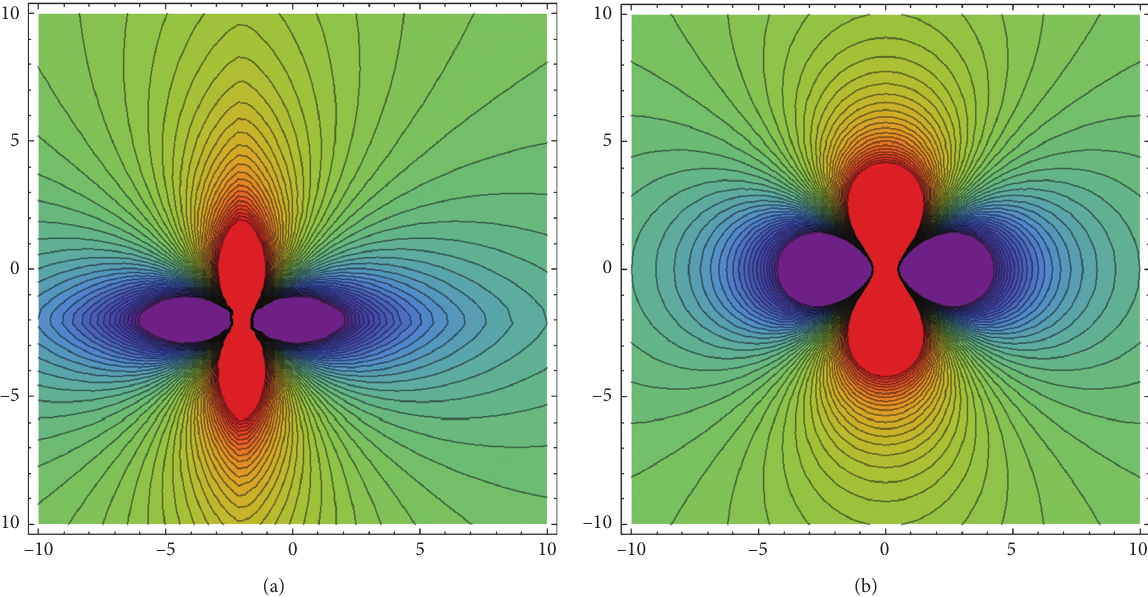
Figure 3: Contours of first-order fractional rogue wave solution (color online) (33) and its comparison with the integer order. (a) α � 5/7 and a � − 2. (b) α � 1 and a �